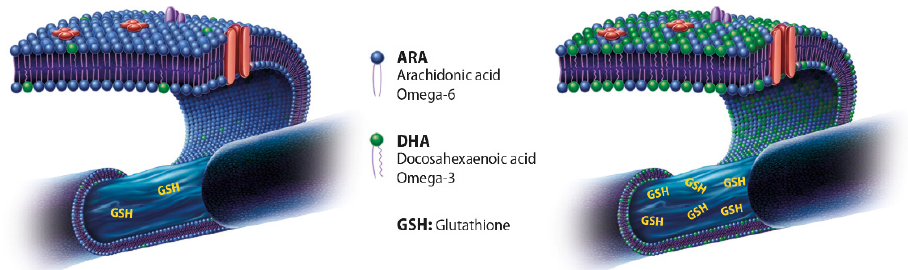
Figure 3. Photoreceptors, as well as other neuron-like cells, have an intensified metabolism, thus cumulating larger amounts of reactive oxygen species (ROS) in their cytoplasm. Moreover, DHA and arachidonic acid (AA) together are almost one fifth of the dry weight. GSH is the main antioxidant produced in the cell’s cytoplasm to scavenge the ROS to avoid membrane oxidation. Appropriate amounts of DHA in the cell membrane are upregulating GSH production, and this is to prevent the oxidation of the double bonds present in the membrane phospholipids. The decrease of photoreceptor membrane DHA after a currently Western diet may result in impaired cellular antioxidant function that can be corrected by increased intake of n-3 PUFAs such as DHA-TG.